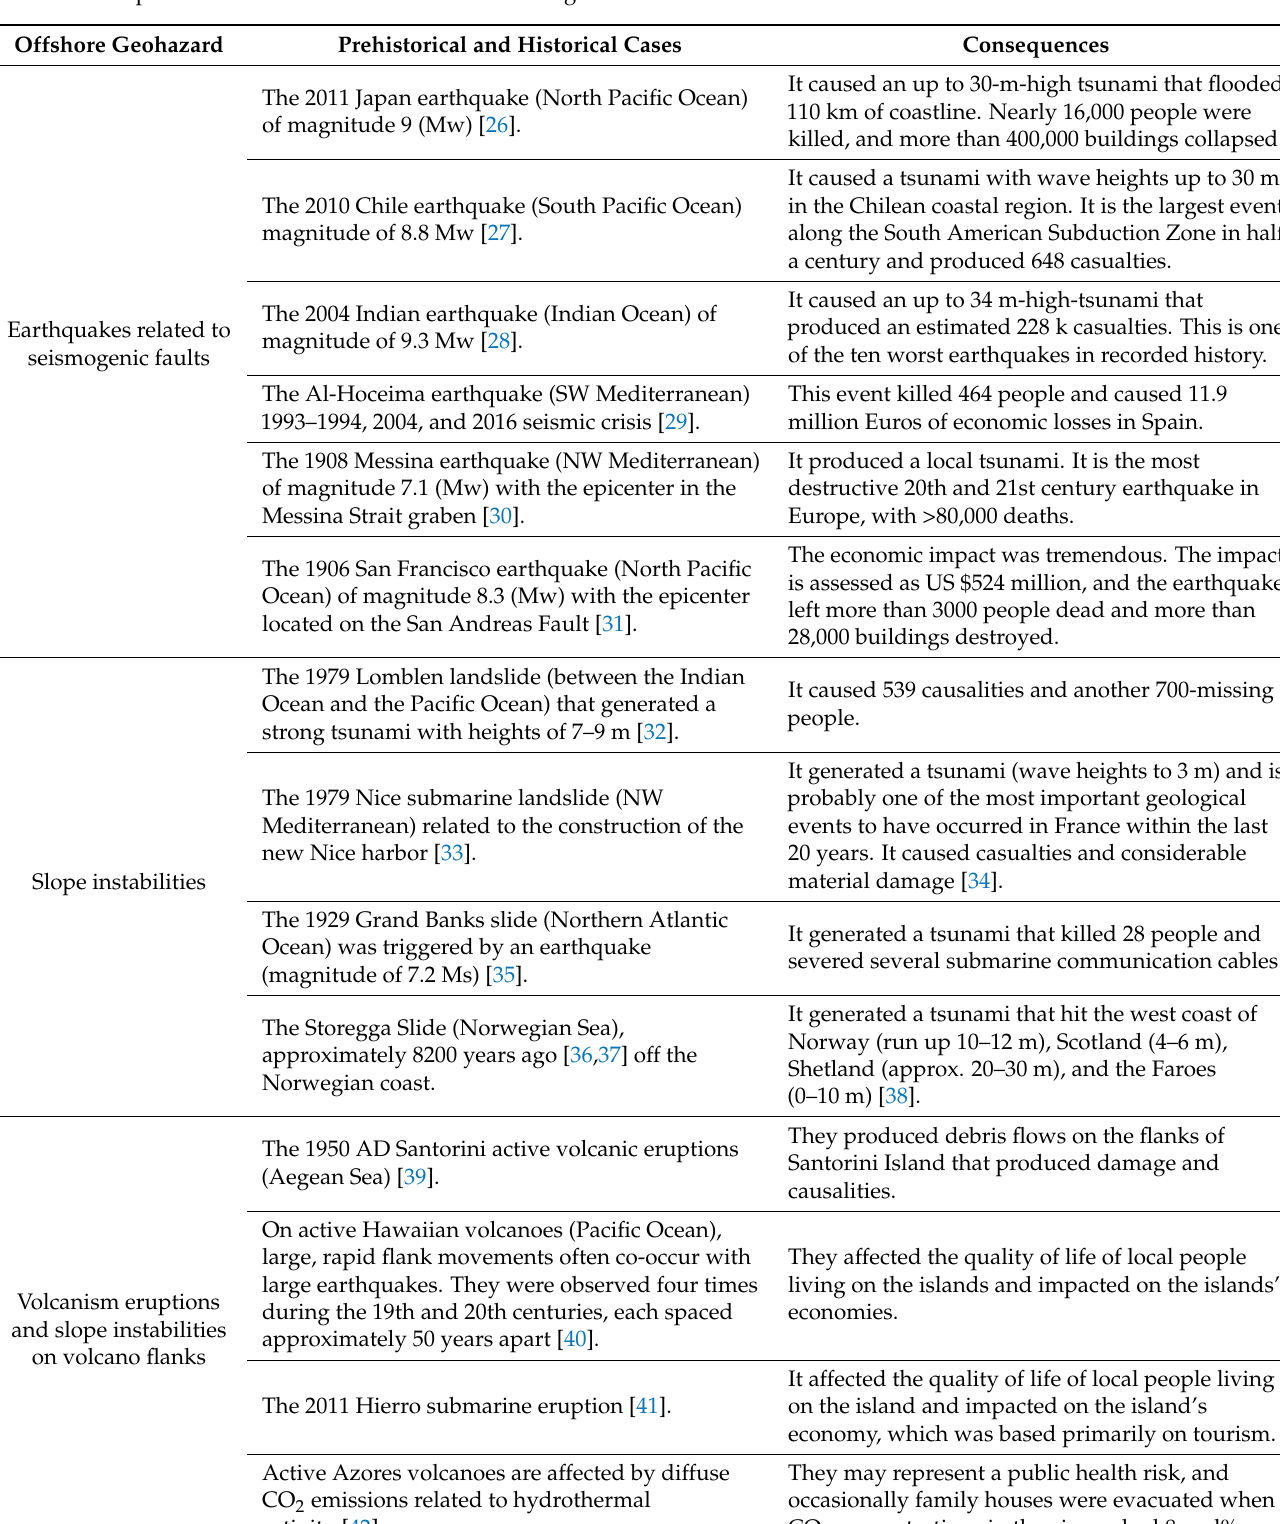
Table 1. Some prehistorical and historical cases of marine geohazard